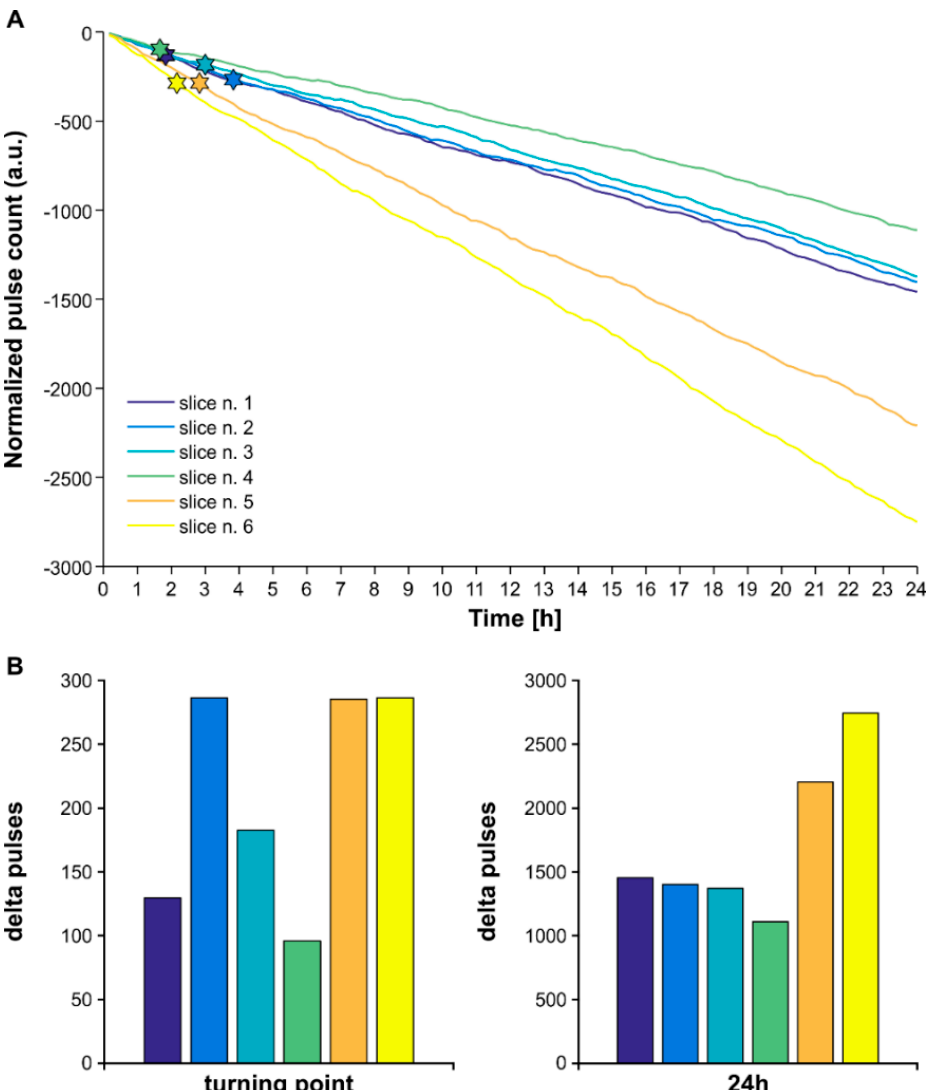
Figure 6. Higher efficiency of lognormal vs. periodic stimulation. ( A ) The cumulative trend of the normalized number of pulses delivered in 24 h by lognormal and matched periodic pulse trains; pulse distribution parameters obtained from the experimental dataset illustrated in Figure 5 ( n = 6 brain slices). The start symbol indicates the time point of significant change in efficiency. ( B ) Count of excess pulses delivered by the periodic versus their respective lognormal stimulus trains at the efficiency turning point indicated in ( A ), and at 24 h. Color-coding as in ( A ).